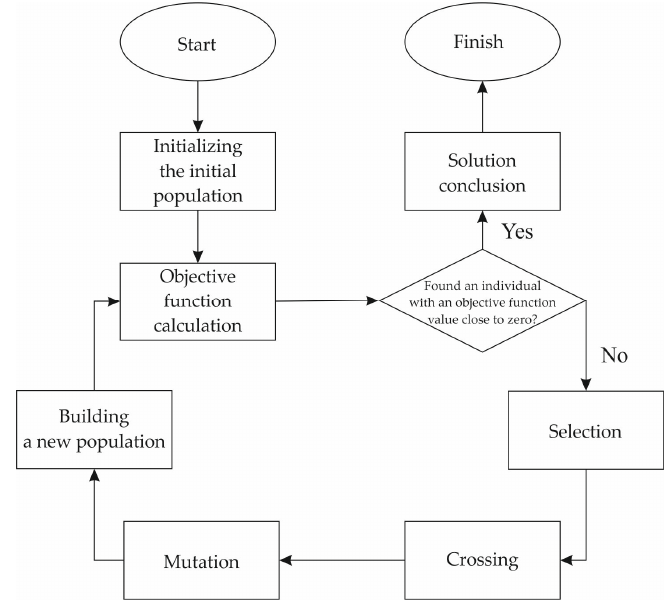
Figure 4. The block scheme of the genetic algorithm.